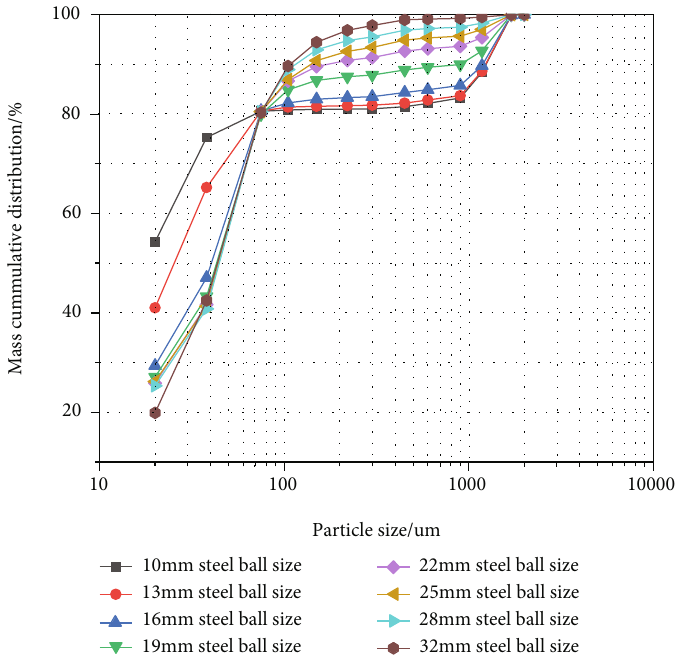
Figure 3: Particle size distribution of products from di ff erent steel ball